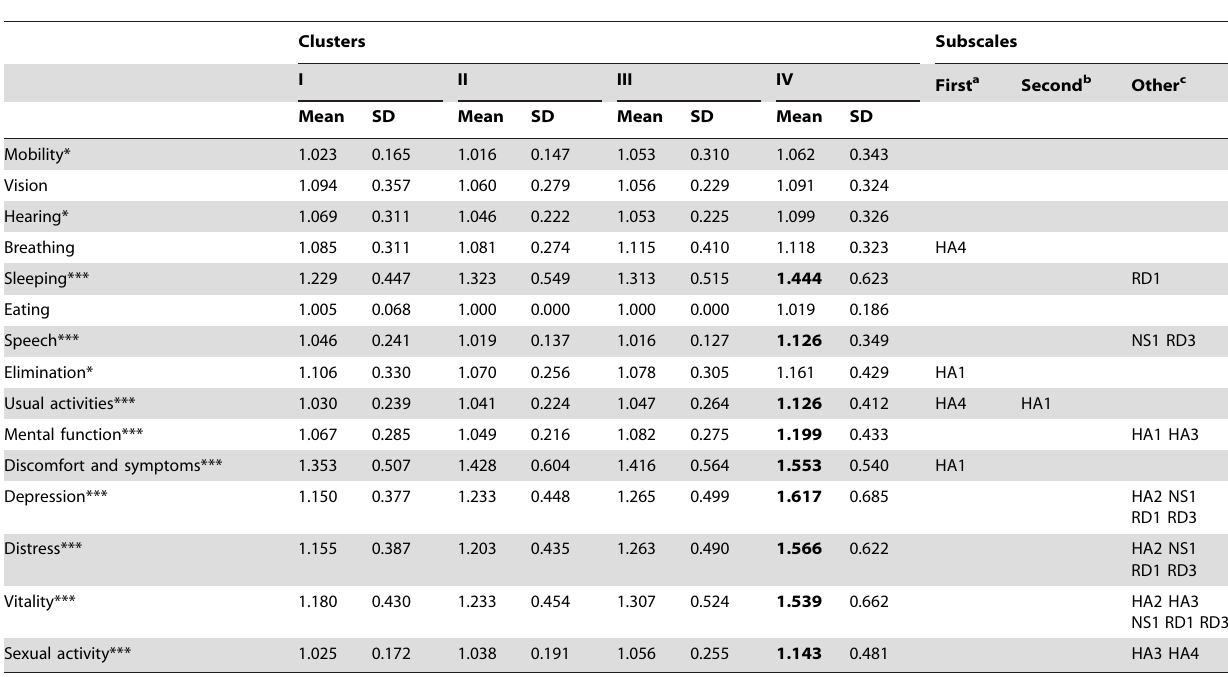
Table 3. Means and standard deviations from 15D questionnaire for males.